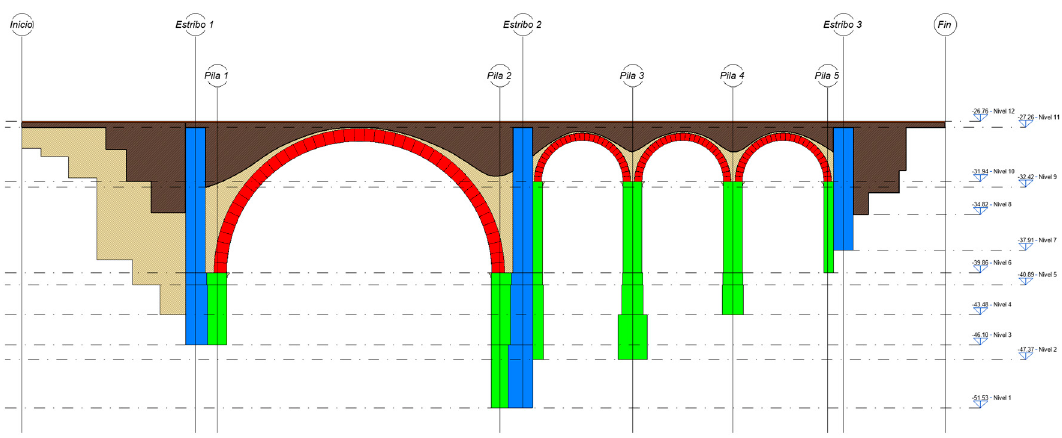
Figure 9. Bridge section by the longitudinal axis .